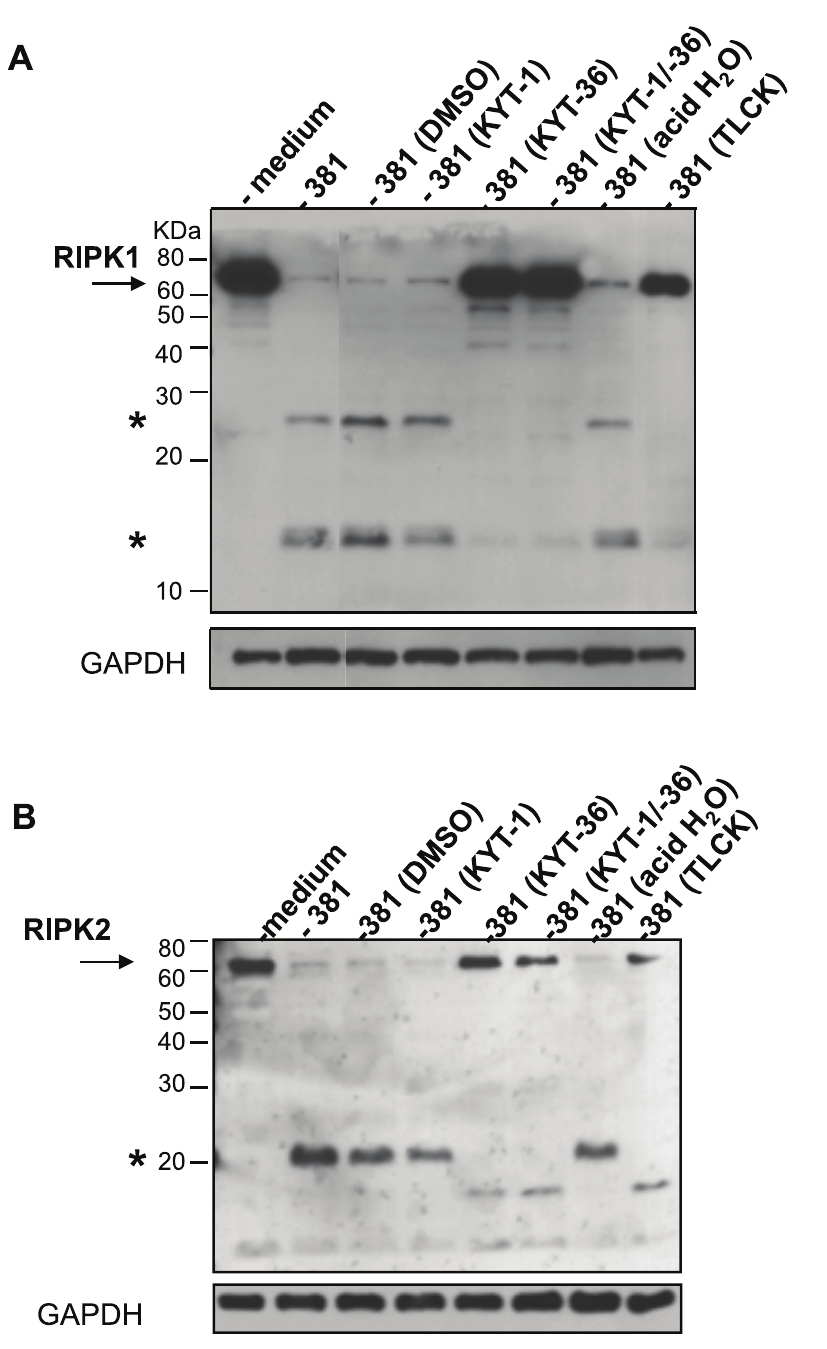
Figure 8. Inhibition of Kgp activity alters P.gingivalis -mediated RIPK1 and RIPK2 cleavage in HAEC. P. gingivalis strain 381 was pretreated with 10 m M KYT-1, 10 m M KYT-36, 10 m M KYT-1 and 10 m M KYT-36, 1 mM TLCK, or vehicle controls (DMSO or acid water) for 45 min. HAEC were then immediately co-cultured with medium or with pretreated preparations of P. gingivalis 381 (MOI 100) for 2 h. Whole cell lysates were analyzed for A ) RIPK1 or B ) RIPK2. Full-length RIPK1 and RIPK2 are indicated with arrows. Prominent P. gingivalis -induced LMW bands are indicated with asterisk(s). MW ladder is indicated on the left in kDa. GAPDH was detected as a loading control.